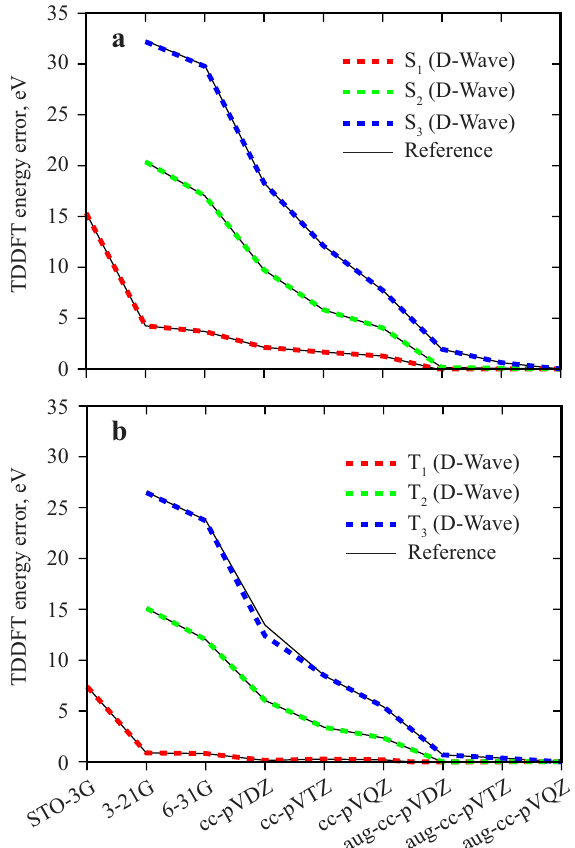
Figure 1. Convergence of TDDFT excitation energies for the H 2 molecule with respect to basis set. Singlet ( a ) and triplet ( b ) calculations are shown separately. The first three excitation energies are computed using PySCF with the QAE and D-Wave 2000Q (dashed red, green and blue curves) and using the unmodified PySCF (thin black curves). The energy error is given relative to the aug-cc-pVQZ reference calculation.